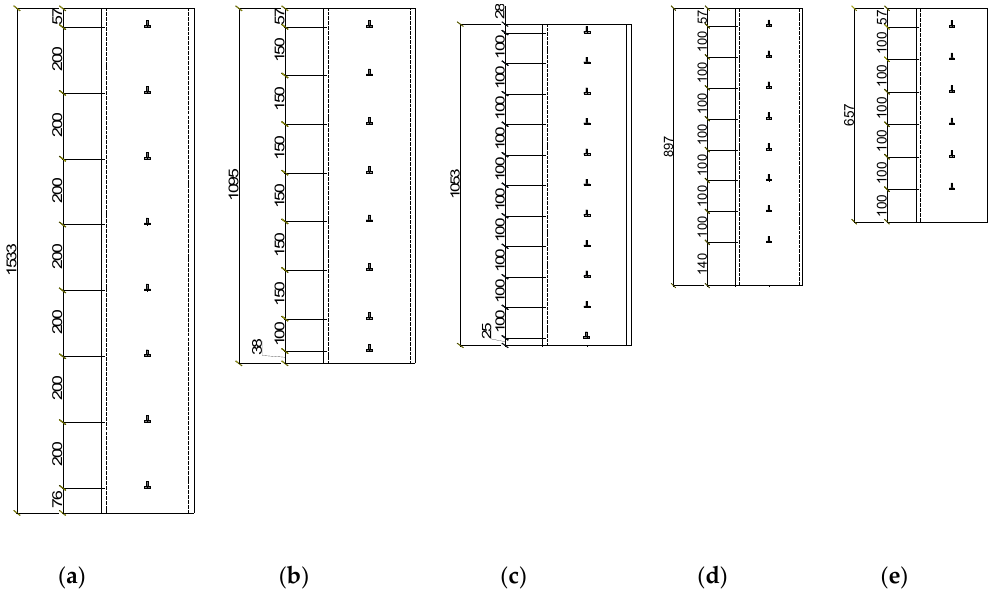
Figure 4. Location of strain gauge on the steel tube: ( a ) CFT-PAC-8; ( b ) CFT-PAC-7; ( c ) CFT-PAC-6; ( d ) CFT-PAC-5; ( e ) CFT-PAC-1~CFT-PAC-4, CFT-NC-1~CFT-NC-3.